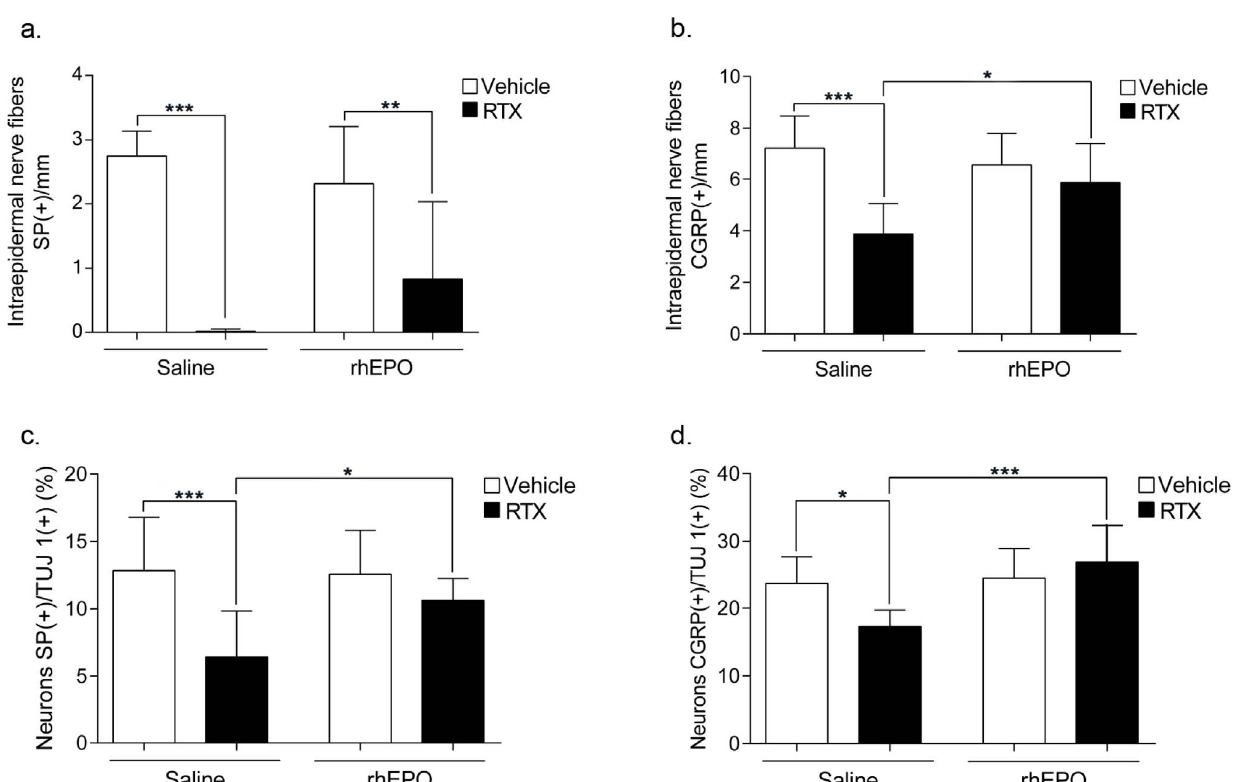
Figure 4. Effects of RTX and rhEPO on IENFs and DRG neurons positive for SP and CGRP. ( a,b ) Footpad skins were immunostained for SP (a) or CGRP (b). The density of IENFs was calculated according to ENFS guidelines [33] (n 5 6 in each group). ( c,d ) DRG neurons were double-immunostained for SP/TUJ-1 (c) or CGRP/TUJ-1 (d). The density of neurons is expressed as neurons SP( + ) or CGRP( + )/neurons TUJ-1( + ). (n 5 12 in each group). 1 way- ANOVA followed Bonferroni’s post-hoc test * p , 0.05, ** p , 0.01, *** p , 0.001. CGRP: calcitonin gene-related peptide, DRG: dorsal root ganglia, IENFs: intraepidermal nerve fibers, rhEPO: recombinant human erythropoietin, RTX: resiniferatoxin, SP: substance P.